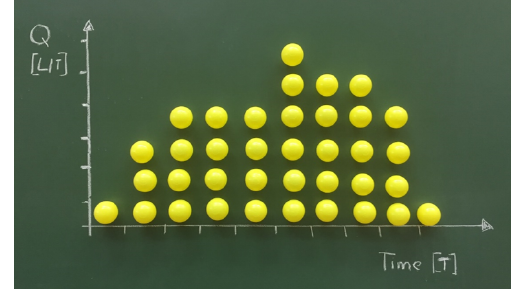
Figure 4. A lecture theatre catchment unit hydrograph resulting from 1mm effective precipitation (represented by a yellow plastic ball) homogeneously spread over the